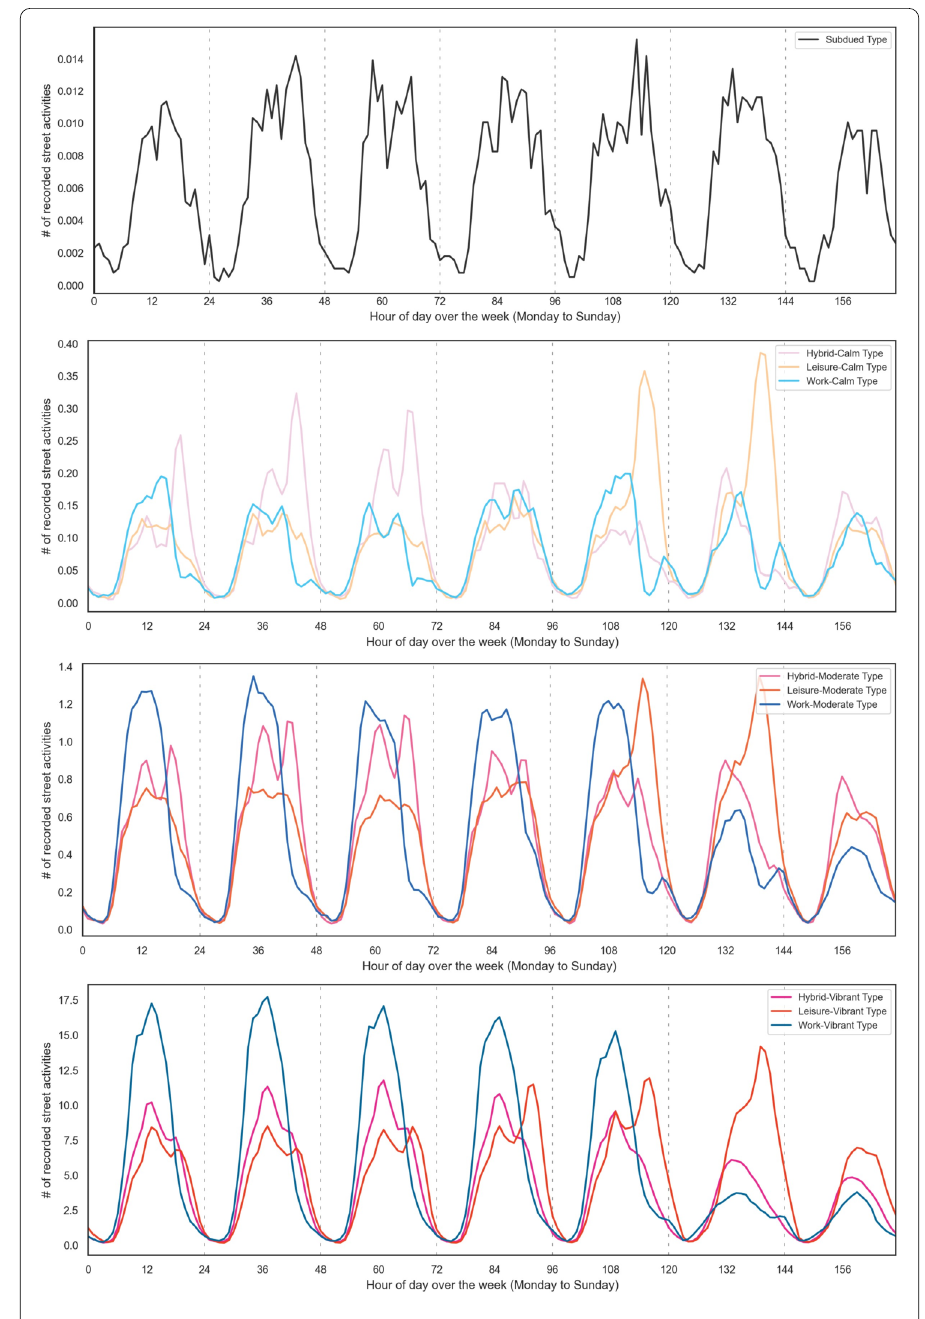
Figure 5 Average street activity rhythms of ASTs